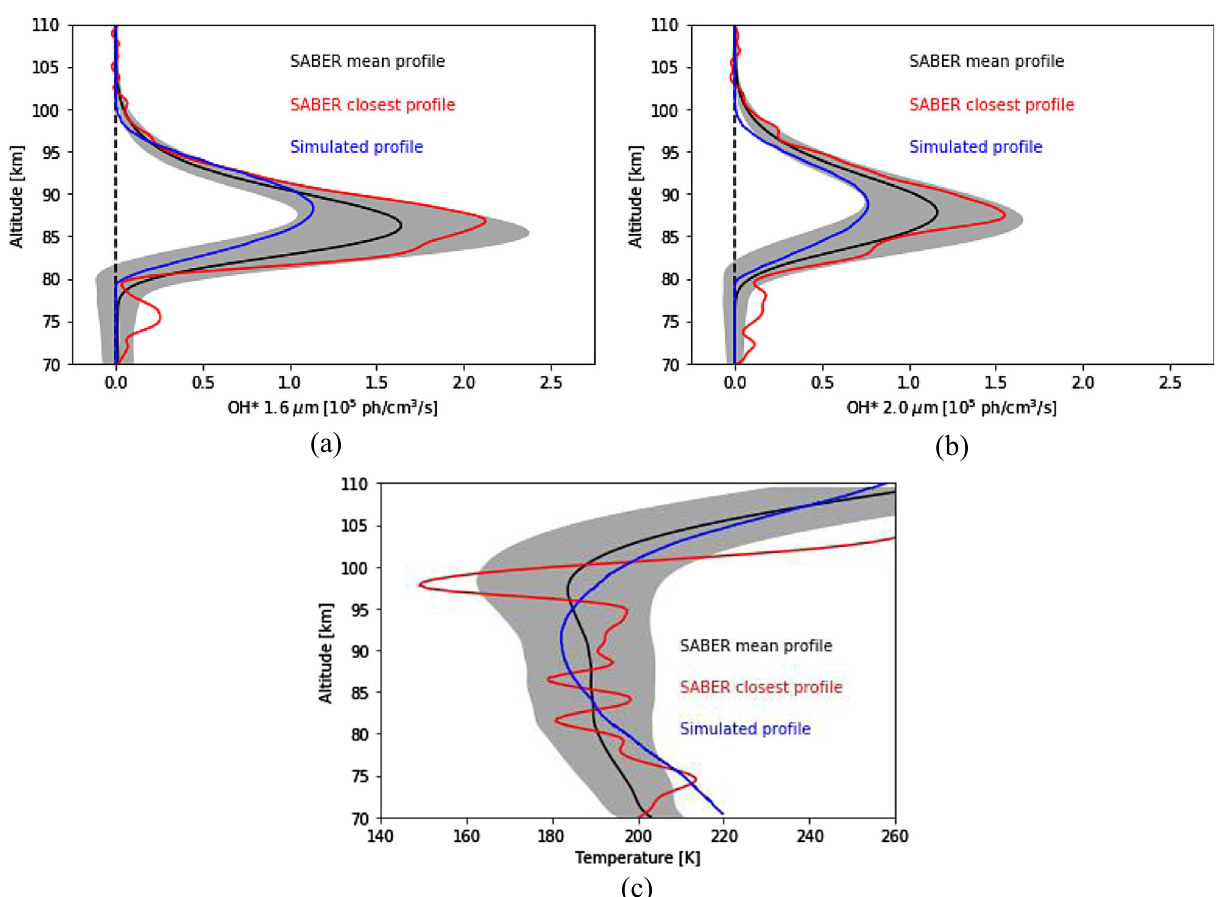
Fig. 5. (a) OH 1.6 l m pro fi les from simulation (in blue), and observations (mean pro fi le in black and closest pro fi le in red). The ±1 standard deviation from the mean is represented with the grey shade. (b) Same as (a) but for OH 2.0 l m. (c) Associated temperature pro fi les. The simulated temperature pro fi le originates from MSIS